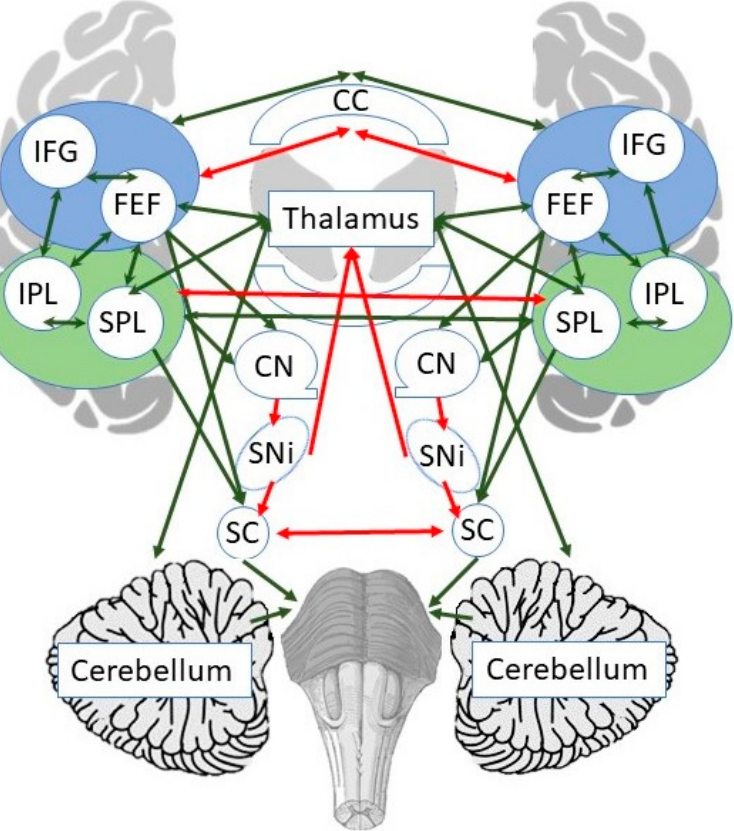
Figure 3. The anatomy of cortico-subcortical connectivity for oculomotor and attentional orienting, which may support prism adaptation. Inhibitory connections shown in red, excitatory connections shown in green. Blue circles denote frontal locations (goal-directed, intentional orienting). Green circles denote parietal locations (stimulus-driven, reflexive orienting). Not all possible connections are shown. CC—Corpus Callosum; CN—Caudate Nucleus; FEF—Frontal Eye Field; IPL—Inferior Parietal Lobule; SC—Superior Colliculus; SNi—Substantia Nigra; SPL—Superior Parietal Lobule.